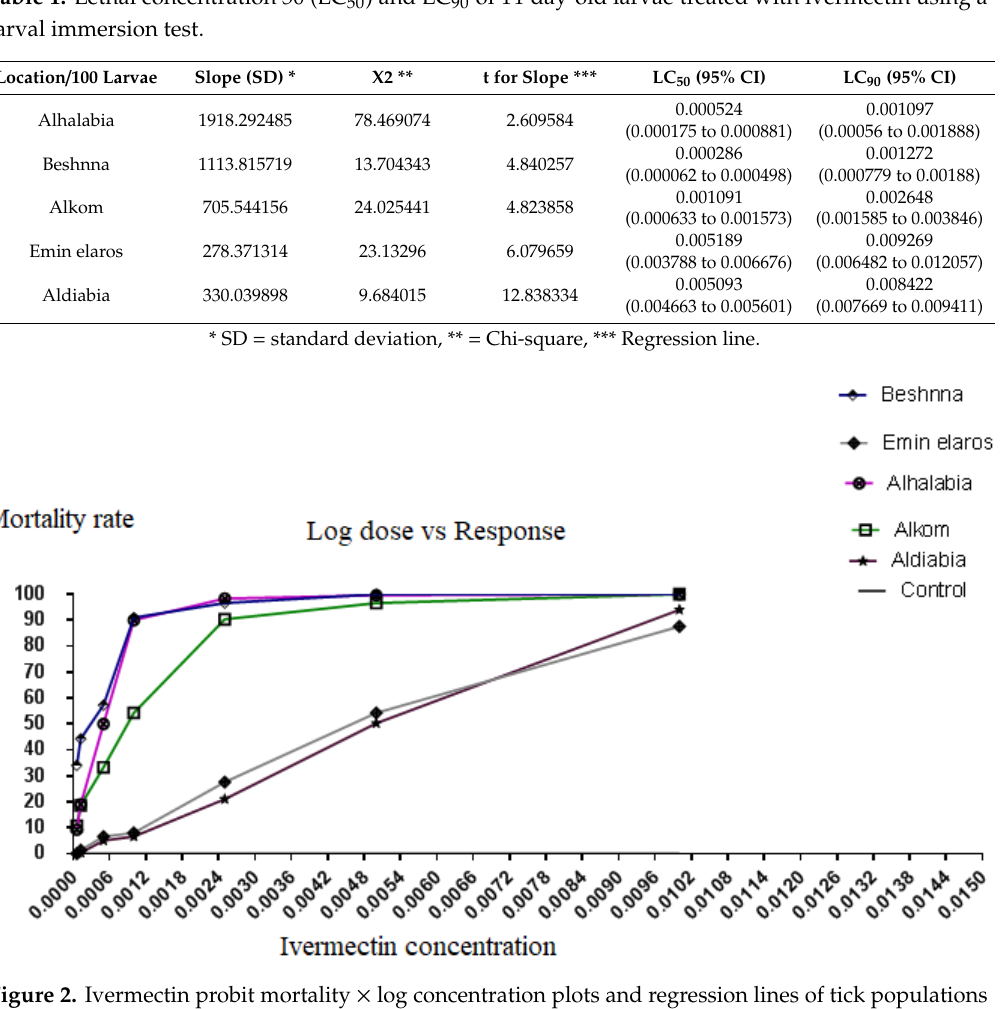
Figure 2. Ivermectin probit mortality × log concentration plots and regression lines of tick populations from the five study areas (Alhalabia, Alkom, Beshnna, Aldiabia, and Eminelaros).